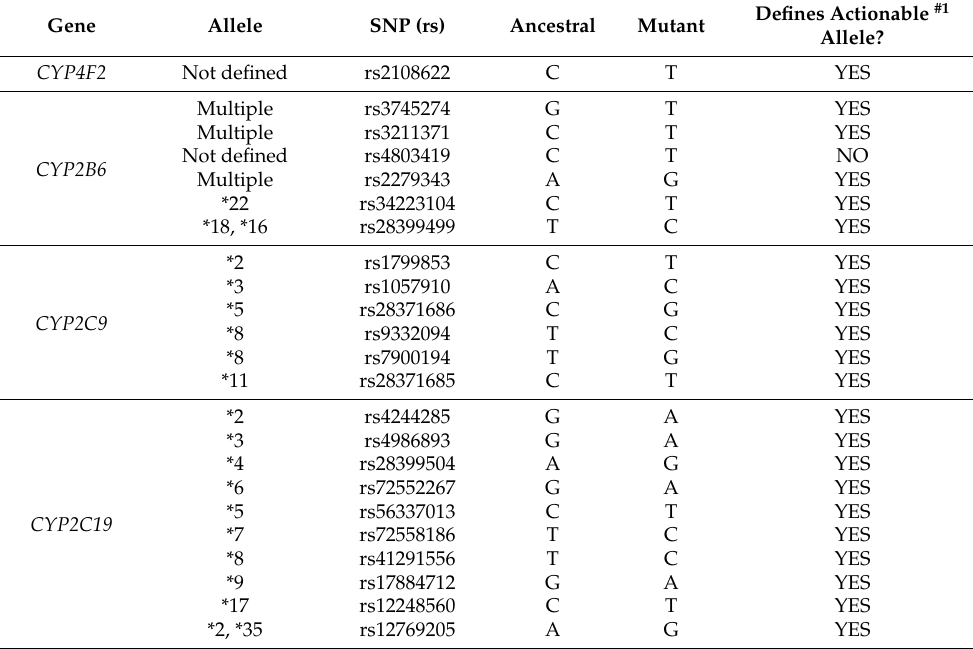
Table 1. Genes and variants included in the VIPOA genotyping